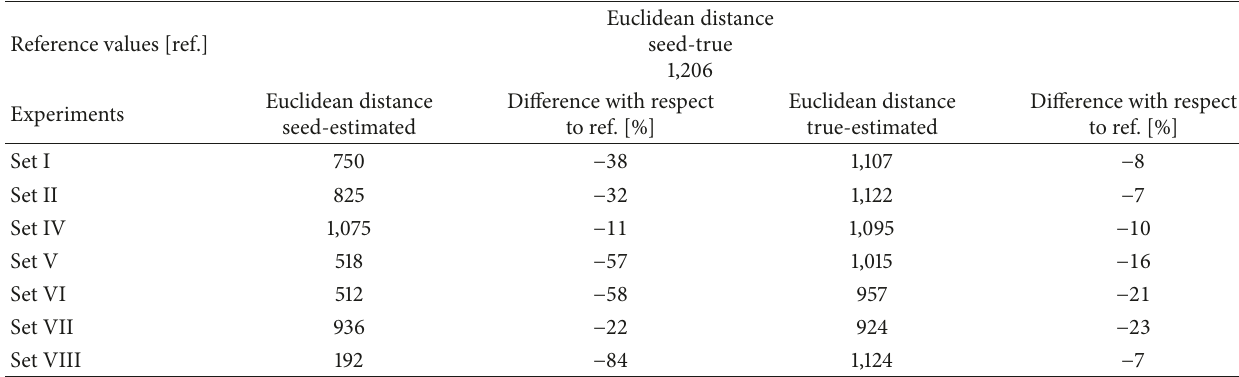
Table 6: Evaluation of the estimated demand in terms of O–D distribution in